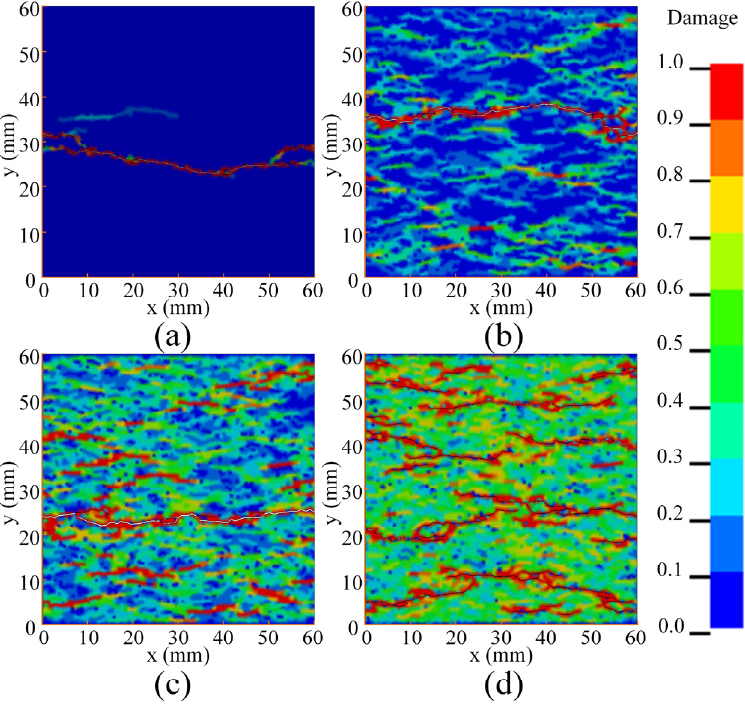
. . ε  ε  ε = 1 s − 1 ; ( c ) ε = 10 1 s − 1 ; ( c ) = 10